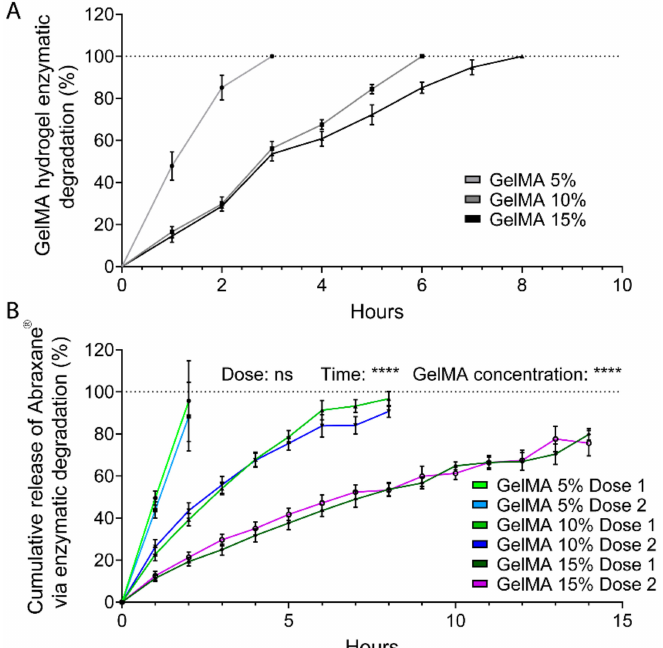
Figure4. ReleasekineticsofFITC-labeledAbraxane ® fromGelMAhydrogelsviaenzymatic(collagenase II) degradation. ( A ) GelMA degradation over time, as measured by mass loss normalized to initial mass. Data are shown as means ± standard deviation (SD), n = 4. ( B ) Cumulative release profiles, normalized to respective free doses suspended in collagenase II. Dose 1 and 2 refer to 37.5 µ g and 75 µ g Abraxane ® , respectively. Data are shown as mean ± SD, n = 4. **** p < 0.0001; *** p < 0.001; ** p < 0.01; * p <